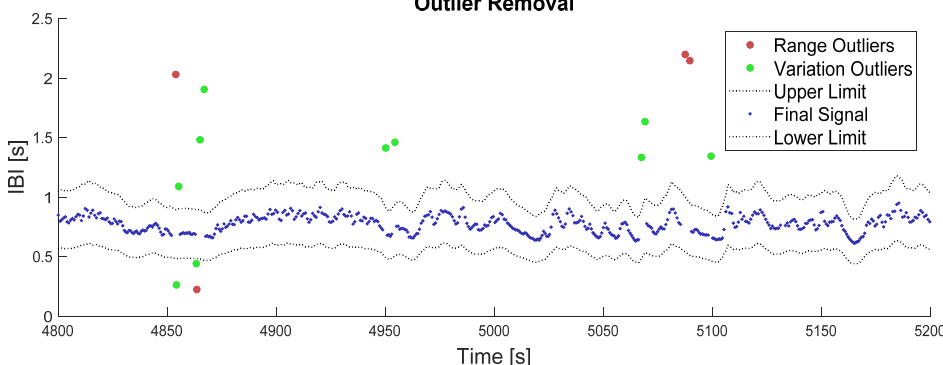
Figure 1. Illustration of the outlier removal process. The red dots represent outliers that were removed in the first place, from the range criterion on IBI values. The green dots represent outliers that have been removed in the second place, from the variation criterion on the IBI signal. The grey dotted-lines represent the final lower and upper limits after algorithm convergence on the variation criterion, i.e., 30% deviation from the moving average. The blue points represent the remaining IBI signal after outlier correction.